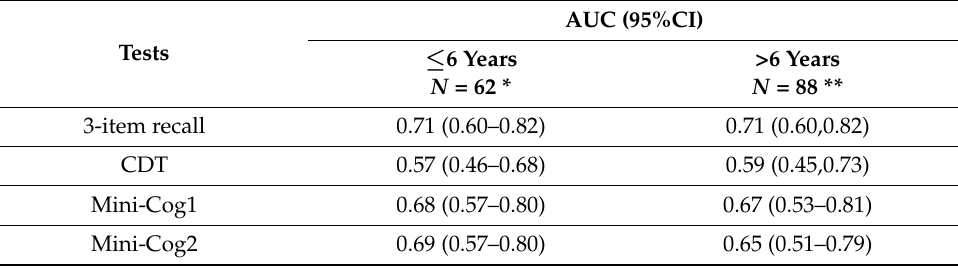
Table 3. Comparison of the overall performance of the three-item recall test, CDT, Mini-Cog1, and Mini-Cog2 by education